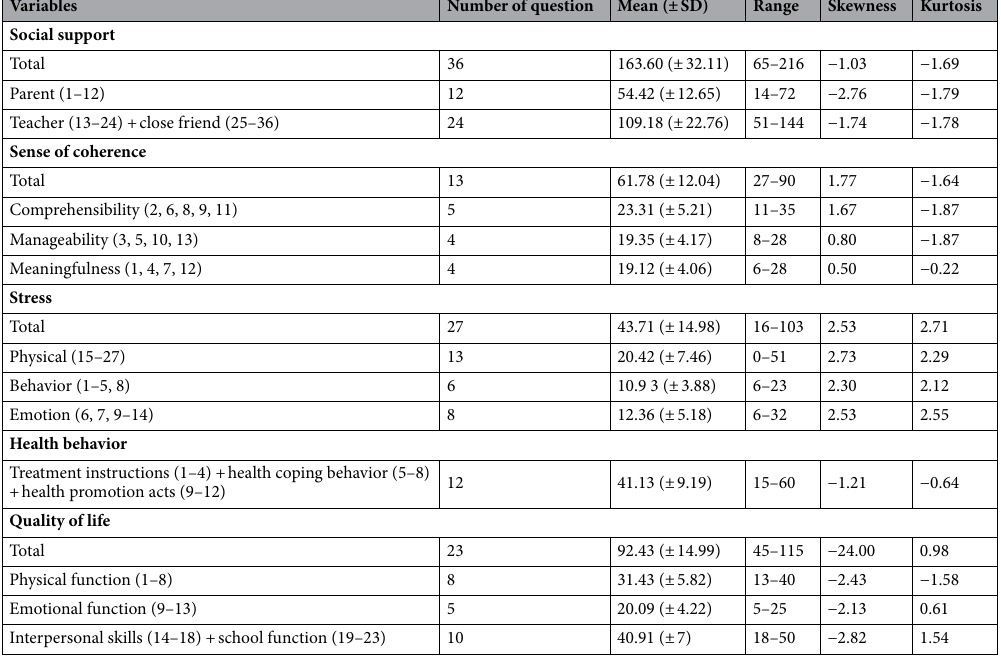
Table 2. Descriptive statistics and confirmatory factor analyses of measured variables (N =